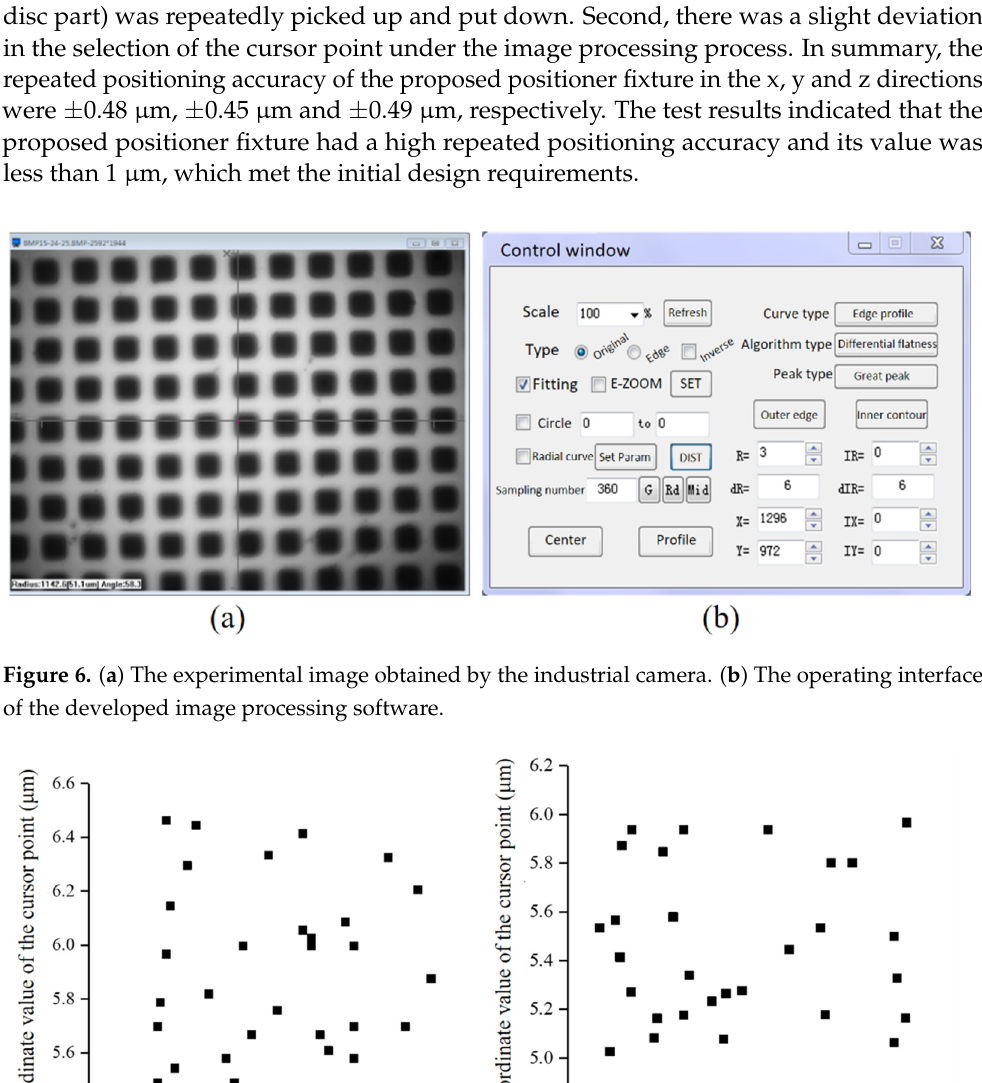
Figure 6. ( a ) The experimental image obtained by the industrial camera. ( b ) The operating interface of the developed image processing software.